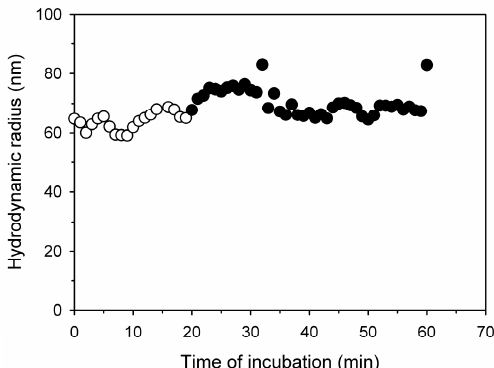
Figure 1. Development of the hydrodynamic radius of the polyplexes with incubation time. White symbols: initial incubation in Hepes-buffered glucose solution (HBG), black symbols: after dilution with Opti-MEM (1 mL), N/P ratio: 20.